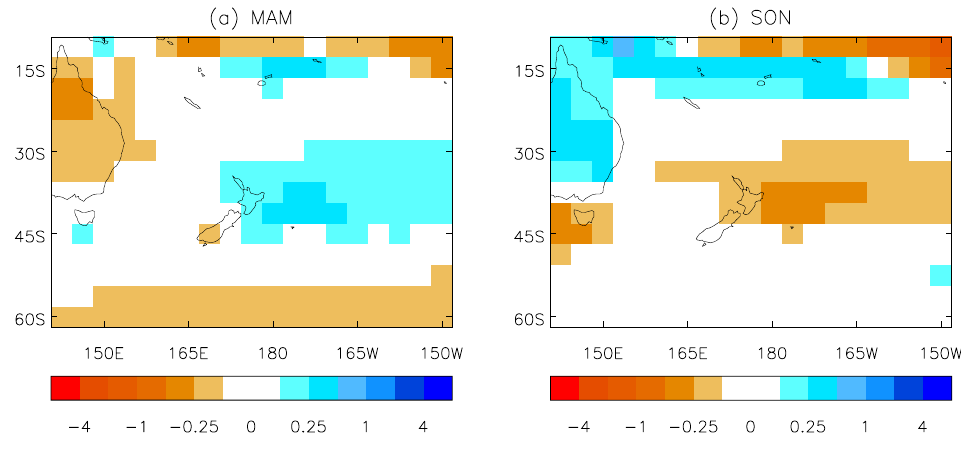
Fig. 13. The ensemble mean change in precipitation (mm day − 1 ) between the PMIP2 Mid-Holocene and the control runs for (a) MAM and (b) SON. Only statistically significant changes ( p ≤ 0.05) are shaded. Refer to Table 1 for more details on each